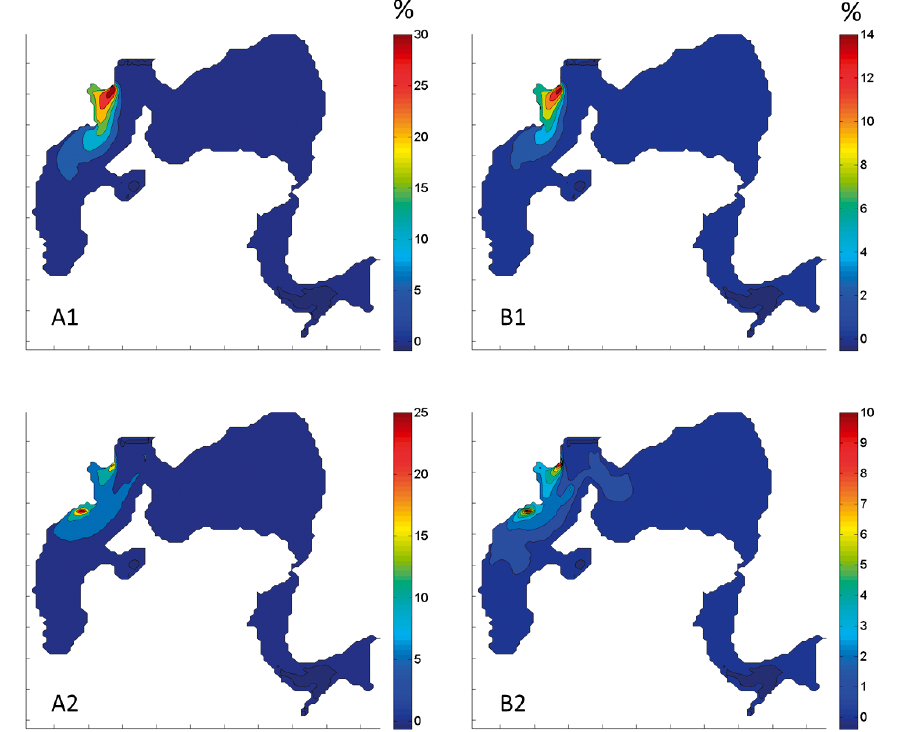
Fig. 5. Modelled spatial effects of mitigation mussel filtration with either 1 large farm (top panels) or 2 smaller farms (bottom panels), resulting in (A) reduction in summer chl a concentration and (B) reduction in light attenuation ( K d ). Results are shown as the nominal relative change (%) between simulations without and with a mussel mitigation farm. Positive values indicate that chl a and K d are reduced in the farm scenario compared to a scenario without mussel mitigation farms